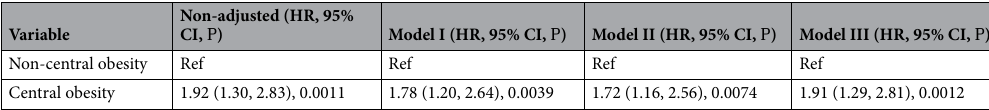
Table 3. Association between central obesity and incident diabetes in different models. Crude model: we did not adjust for other covariates. Model I: we adjusted for age, BMI, gender, smoking status, ethanol consumption, regular exerciser, SBP, DBP. Model II: we adjusted for age, BMI, gender, smoking status, ethanol consumption, regular exerciser, SBP, DBP, ALT, AST, GGT, HbA1c, FPG, TC, TG, HDL-C. Model III: we adjusted for propensity score. HR hazard ratios, CI confidence interval, Ref